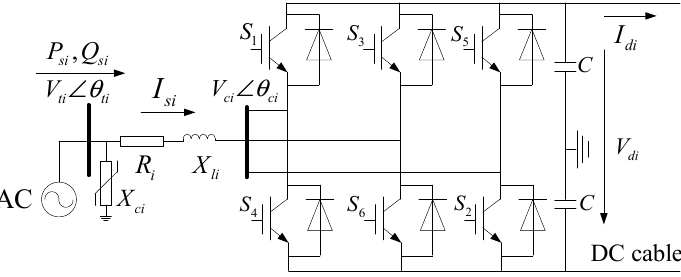
Figure 1. Steady-state physical model of VSC-MTDC network. VSC: voltage source converter; MTDC: multi-terminal direct current.